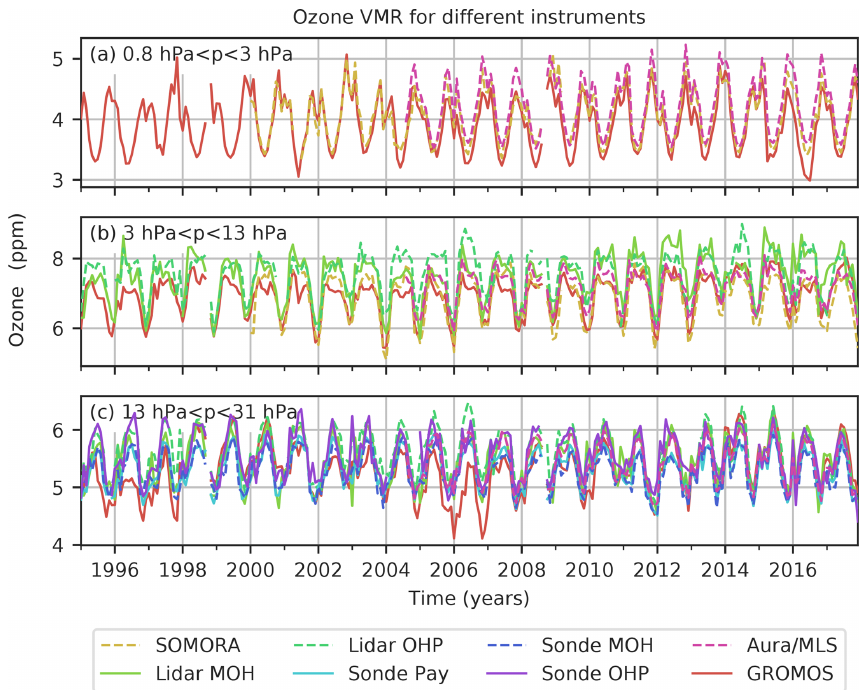
Figure 2. Monthly means of ozone VMR from the microwave radiometers GROMOS (Bern) and SOMORA (Payerne), the lidars at the observatories of Hohenpeissenberg (MOH) and Haute Provence (OHP), and the ozonesonde measurements at MOH, OHP, and Payerne, as well as Aura/MLS data above Bern. The data have been averaged over three altitude